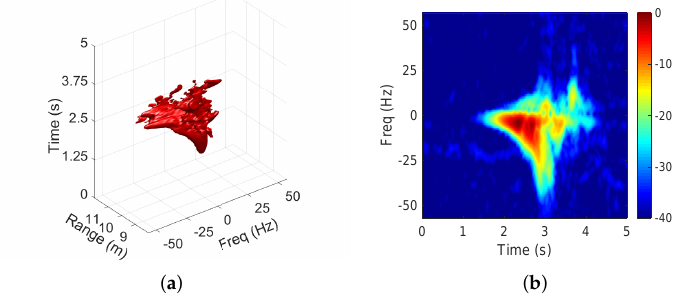
Figure 1. ( a ) RDC for falling, and ( b ) R-max TFR for